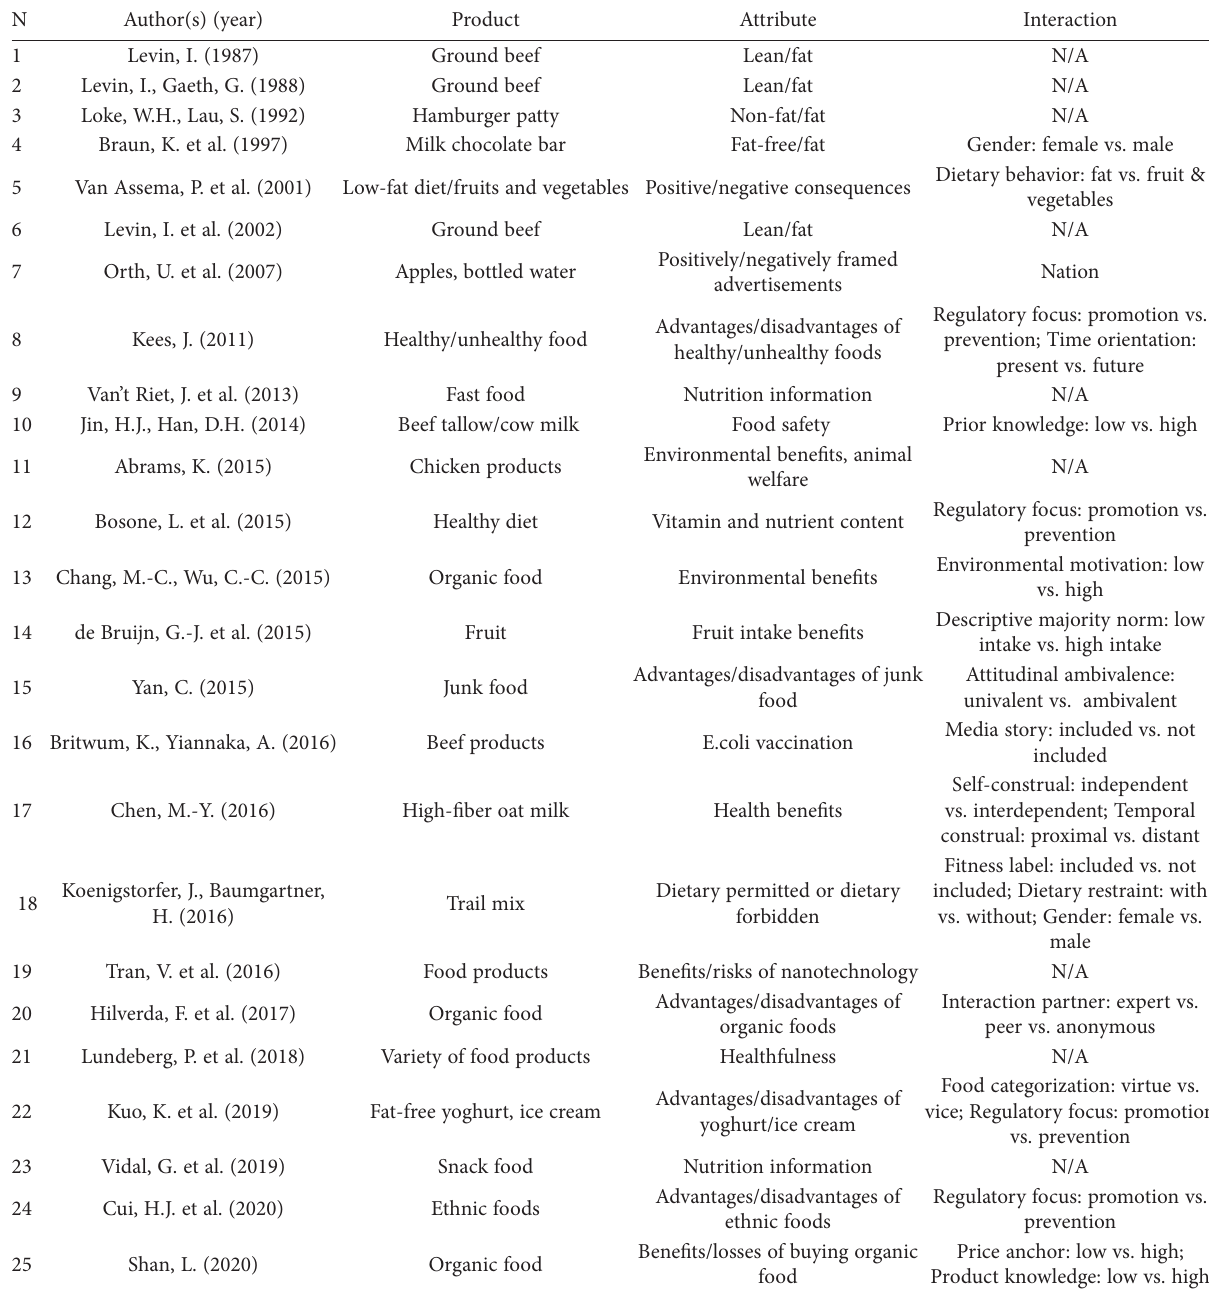
Table 1. Products and attributes of the studies included in the analysis (by year of publication) N Author(s)